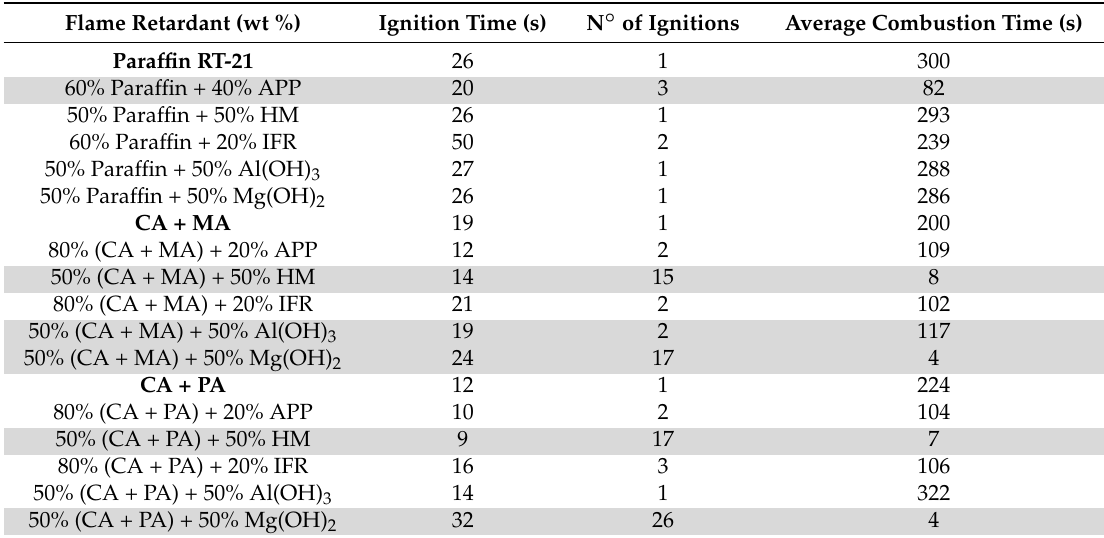
Table 4. Dripping test results for